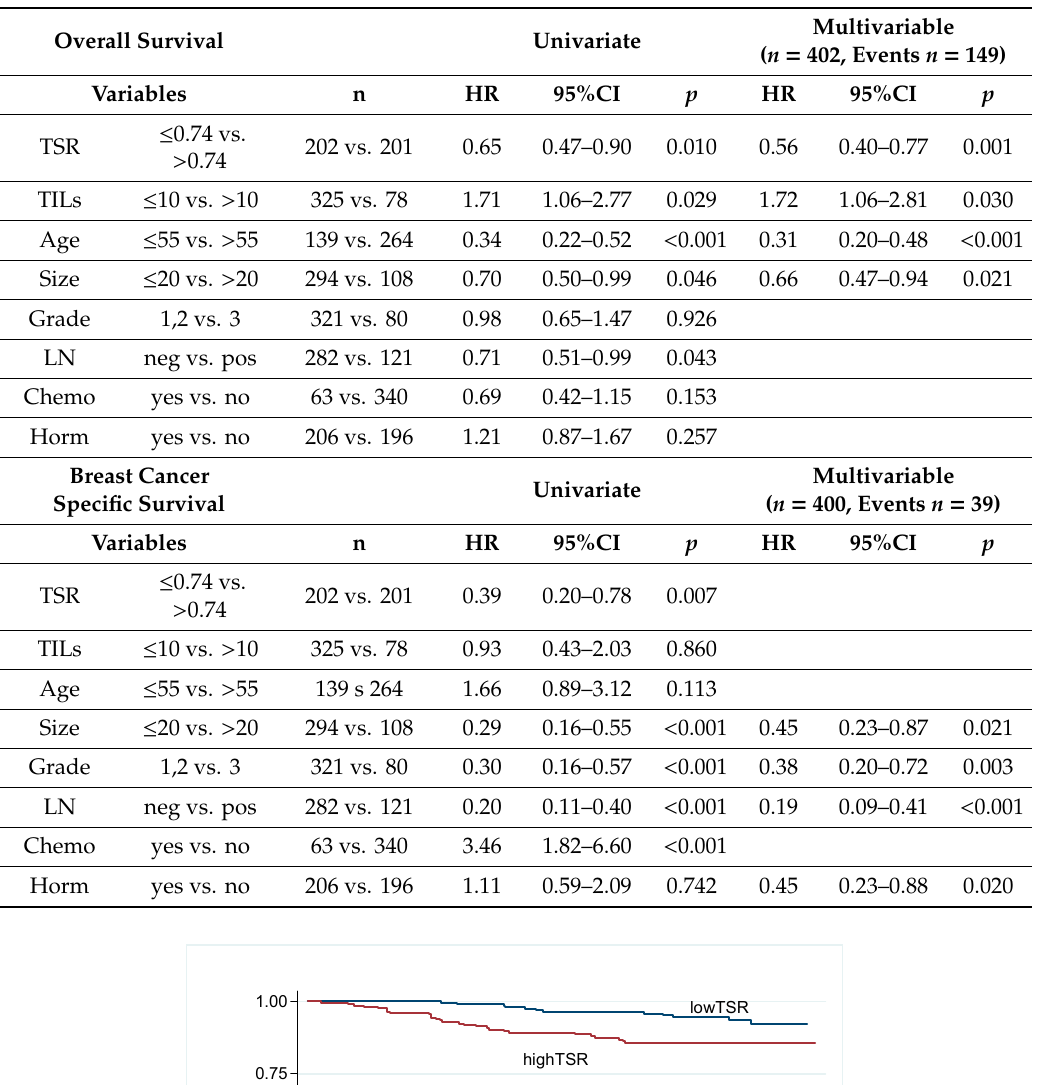
Table 2. Univariate and multivariate analysis for OS and BCSS in luminal ER + breast cancer.